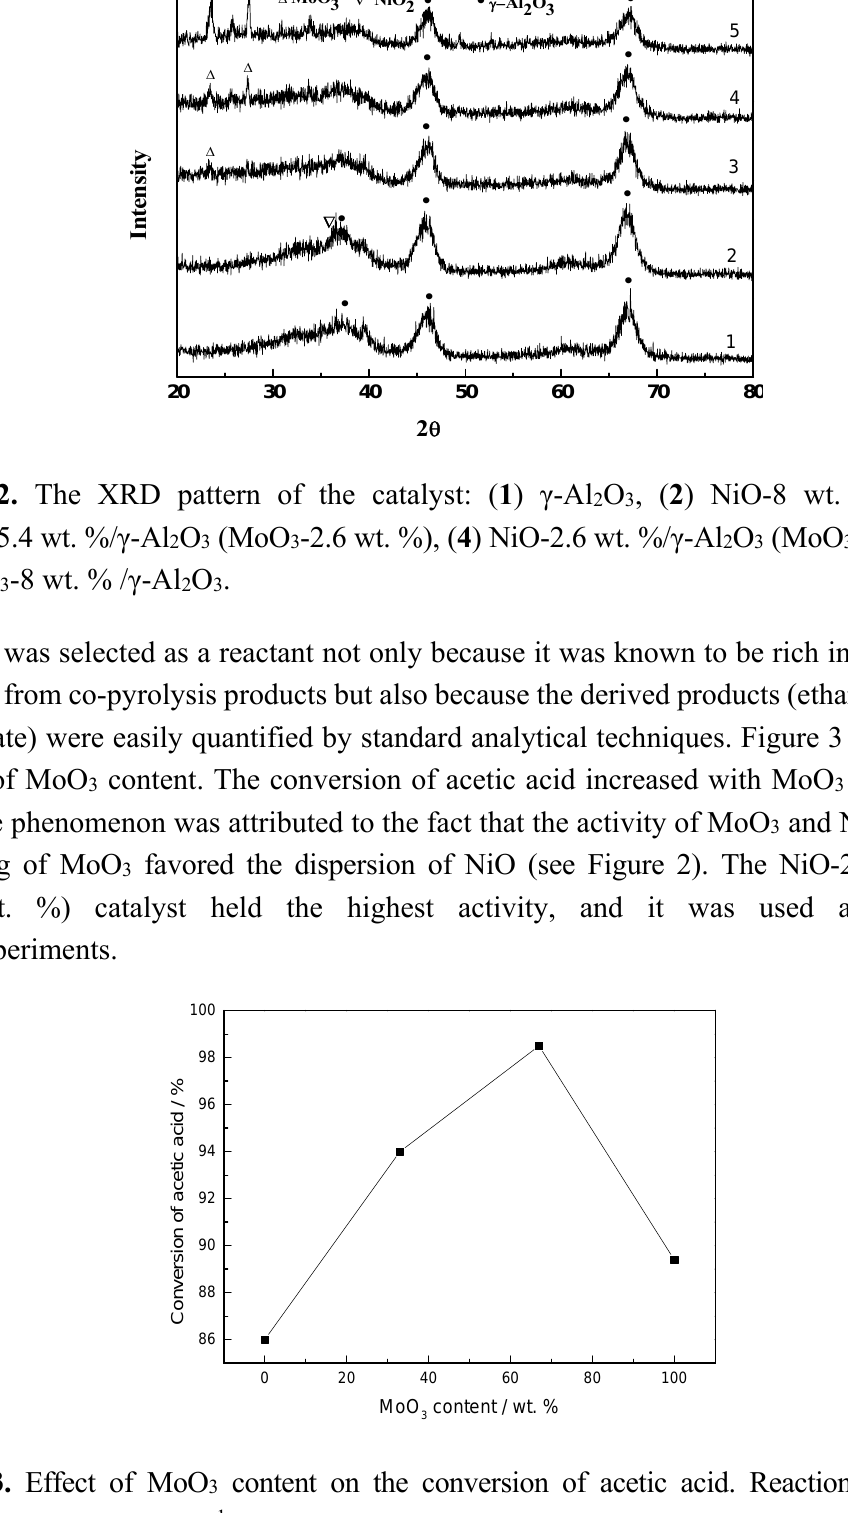
Figure 3. Effect of MoO 3 content on the conversion of acetic acid. Reaction conditions: P = 3 MPa, WHSV = 1.5 h − 1 , H 2 /feedstock =